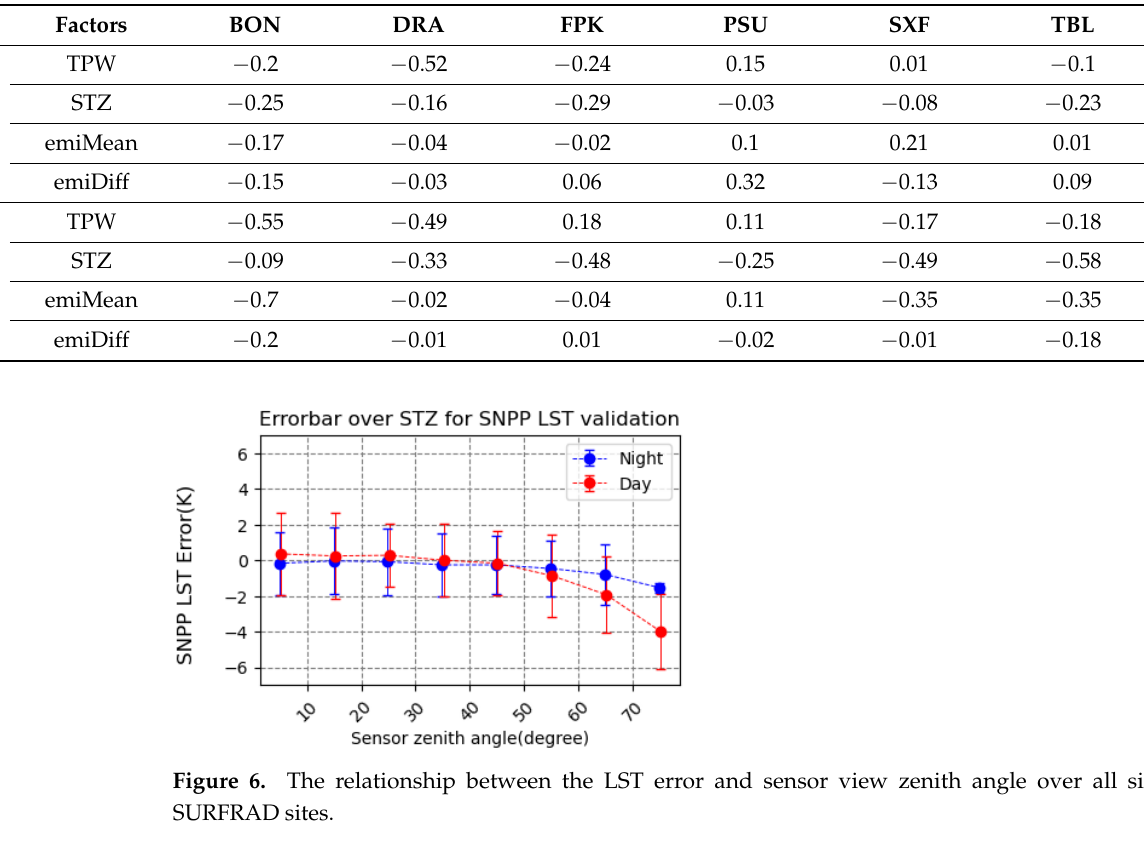
Table 4. Correlation between LST error and multiple factors for nighttime and daytime.